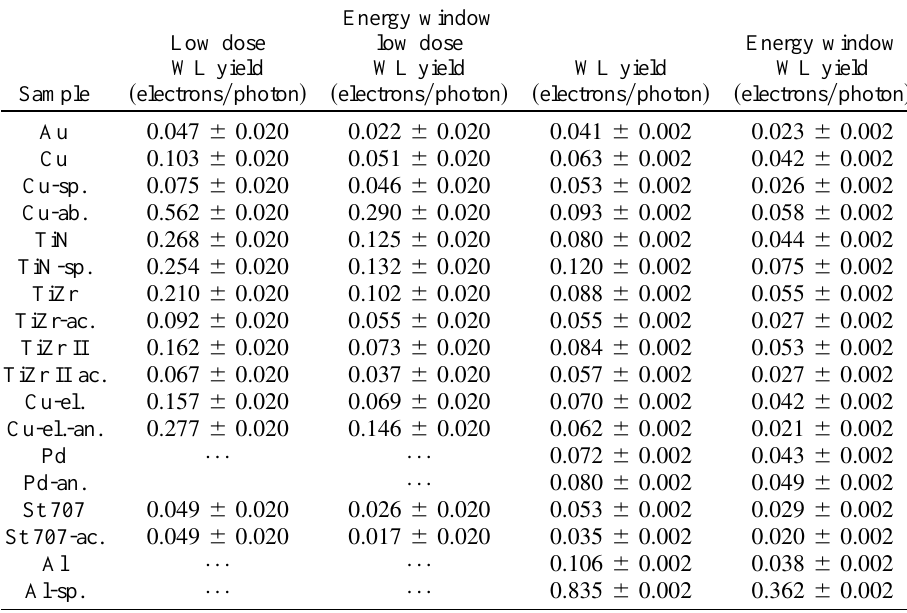
TABLE IV. The low dose WL total yield, reconstructed from a summation of the EDCs, high photon dose WL total yield measured with WL, and corresponding WL yield in the energy window, 1–6 eV, for the different samples